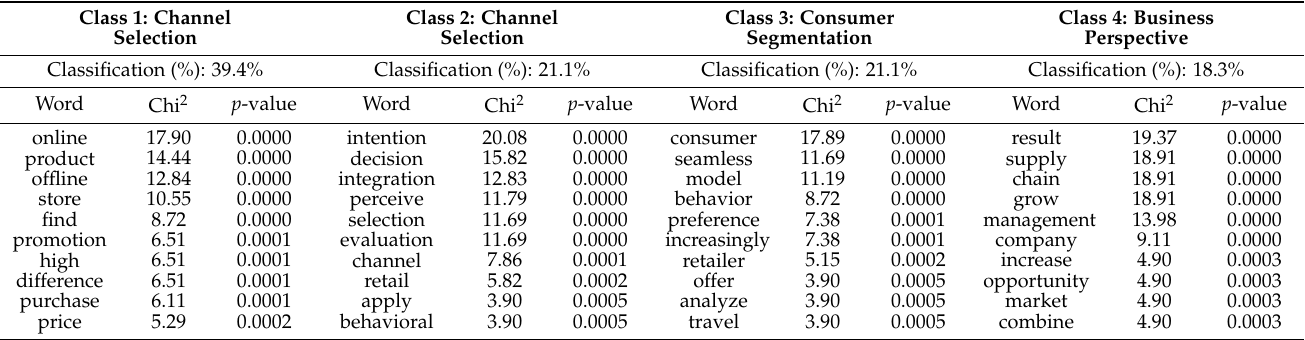
Table 4. Typology analysis: purchase stage.